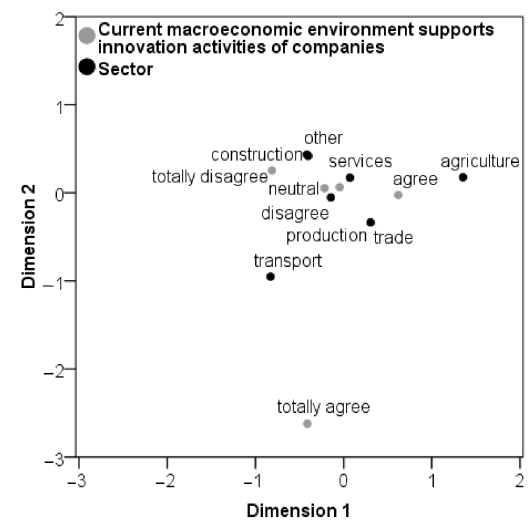
Figure 10. Correspondence analysis/the Czech Republic